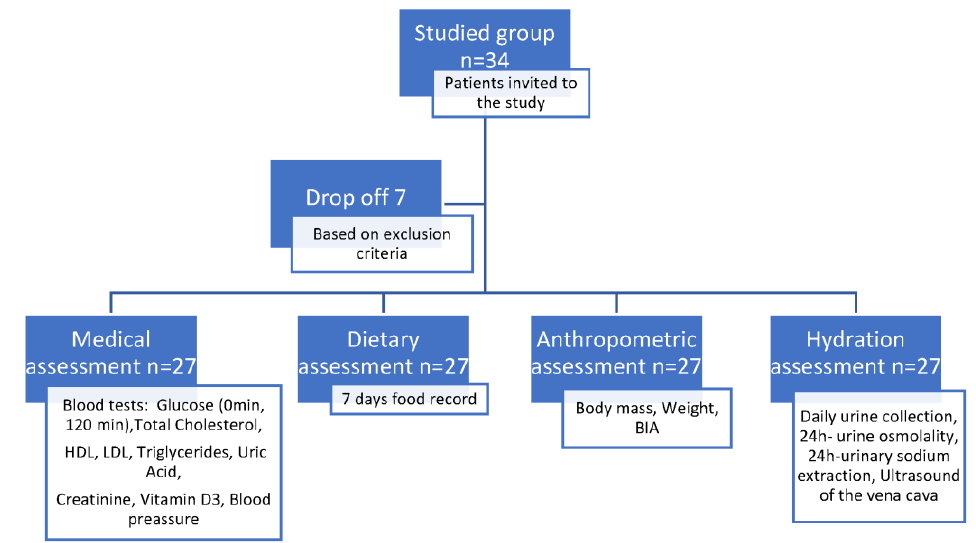
Figure 1. Study group and data collection. h: hours.